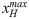
Dynamic evolution of mechanical degrees of freedom and survival probability for CCMV shell.Panel (a) exemplifies the dynamics of Hertzian deformation x
H and beam-bending deformation x
b vs. X in the Hertzian regime I and in the transition regime II. Model calculations are performed using parameter values obtained from the fit of theoretical FX-curves to the simulated average FX-spectra for CCMV nanoindentation along the 2-fold symmetry axis (Table 1). The solid curves correspond to the exact method of parameter estimation; the dashed and dashed-dotted curves are for the (piece-wise) approximate method of estimation. Snapshots exemplify the local flattening of CCMV structure under the tip for X = 1 nm and 5 nm deformation. Panel (b) displays the results of overlap function χ-based estimation of the survival probability s(X) from simulations of CCMV nanoindentation (ν
f = 1.0 μm/s, R
tip = 20 nm, and κ = 0.05 N/m; S3a Fig) along the 2-fold (red), quasi-3-fold (blue), and quasi-2-fold symmetry axes (green). The theoretical profiles of s(X) (solid curves; see Eq (16)) are compared with the simulated profiles of χ(X) (data points; see Eq (15)). The model parameters are summarized in Table 1. The values of xHmax are obtained using Lagrange multipliers and the approximate method of parameter estimation (see Discussion).